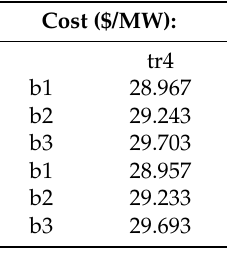
Table A3. The slope of segment b of the cost curve for unit i ($/MW): k( i , b ).